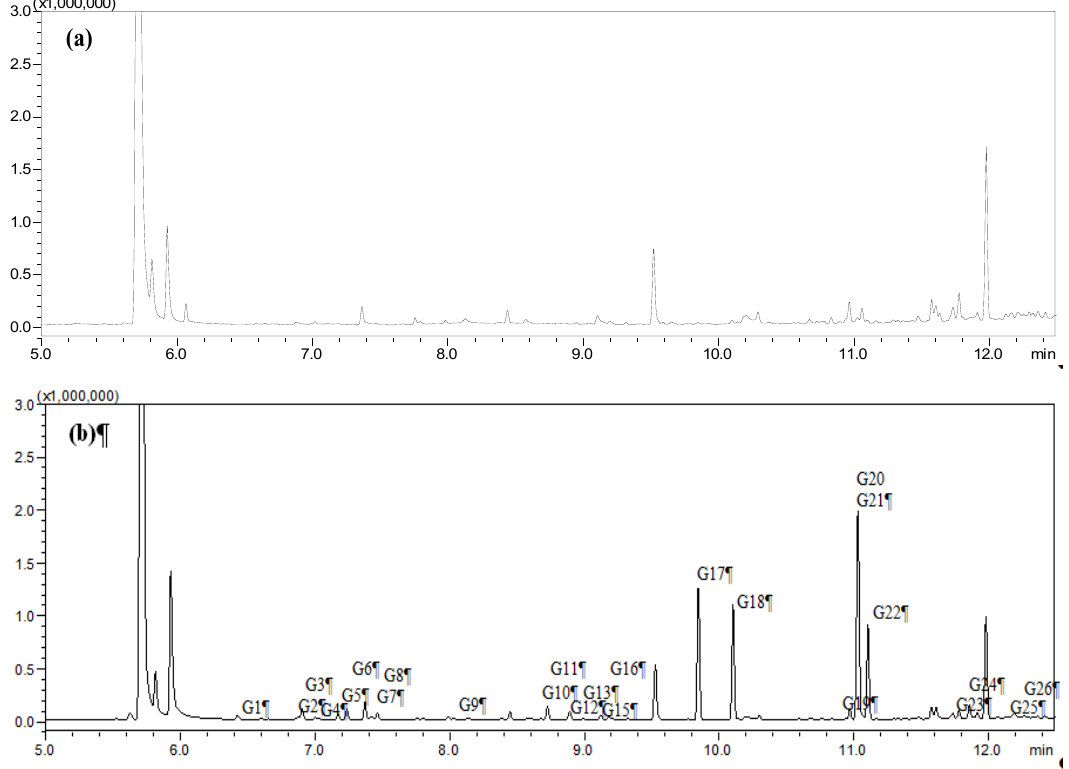
Figure 1. Total ion chromatograms of plasma obtained from ( a ) blank group and ( b ) Asari Radix et Rhizoma (AR) EtOAc extract group using